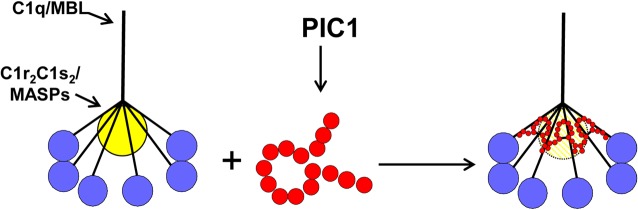
Model of PA inhibition of C1/MBL function.Our data favors a model in which PIC1 derivatives functionally disrupt the C1s-C1r-C1r-C1s/MASP interaction with the CLR of C1q/MBL, respectively. By PIC1 binding to the serine protease interaction site on CLR, the serine proteases are hypothesized to be in a suboptimal conformation for autoactivation and initiation of the classical and/or lectin pathways of complement.